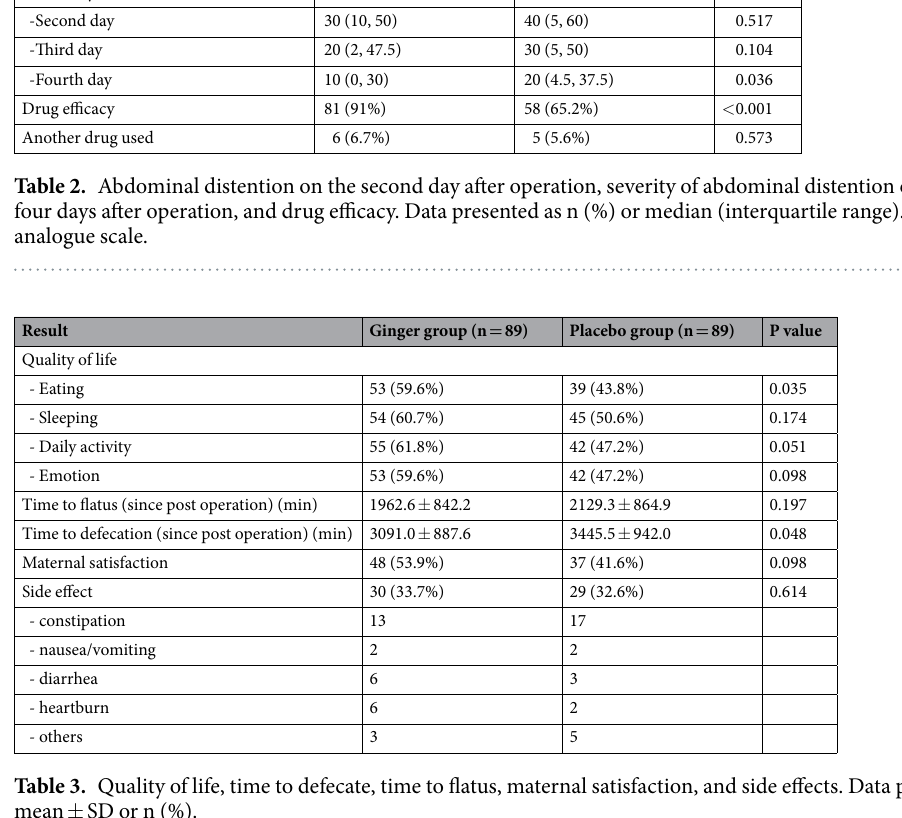
Table 3. Quality of life, time to defecate, time to flatus, maternal satisfaction, and side effects. Data presented as mean ± SD or n